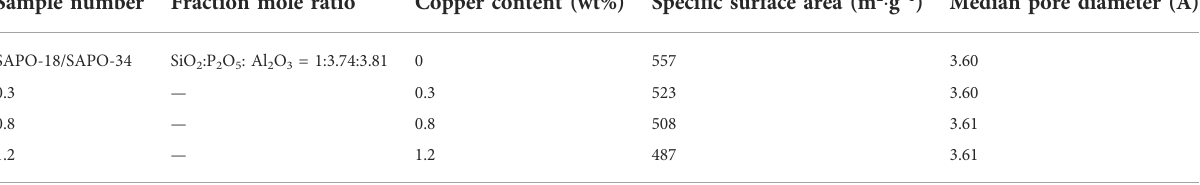
TABLE 1 XRF and BET results of SAPO-34/SAPO-18 zeolite and its catalysts. Sample